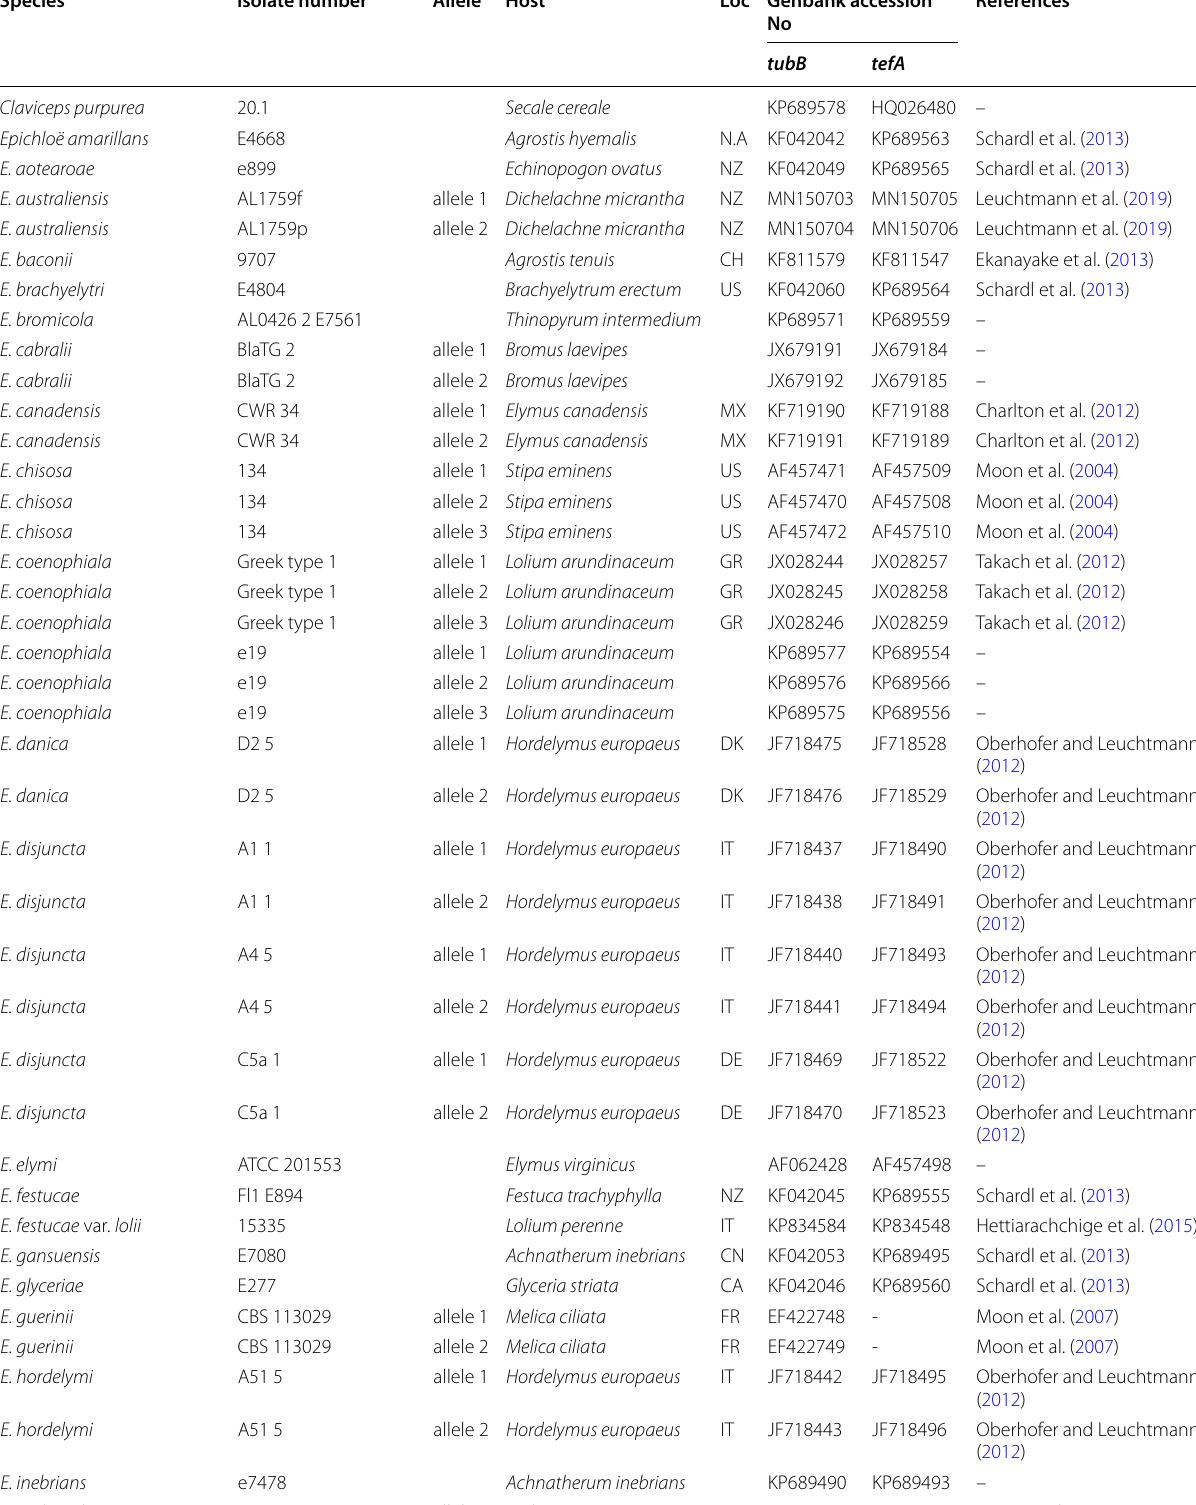
Table 1 Table of taxa. Sequences in the tefA and tubB alignments used for the multigene phylogeny Species Isolate